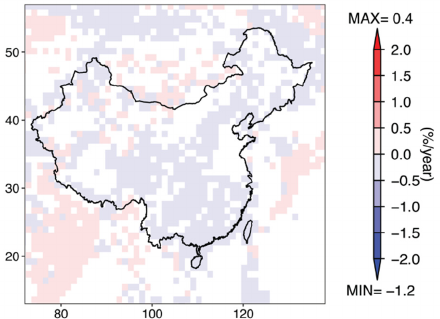
Figure A1. Temporal trend of forest fraction from 1982 to 2013 derived from LUH dataset (color bar is the slope in percentage per year).